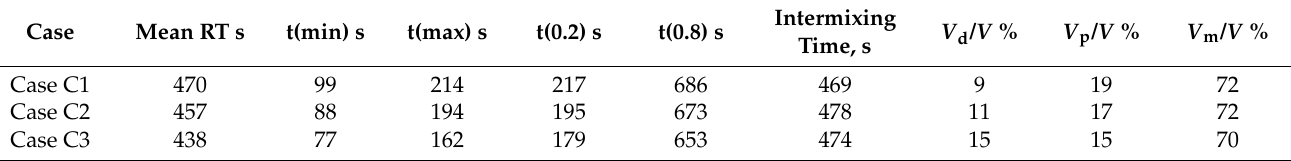
Table 6. Computational RTD parameters and the volume fraction of flow for Case C1, C2 and C3.